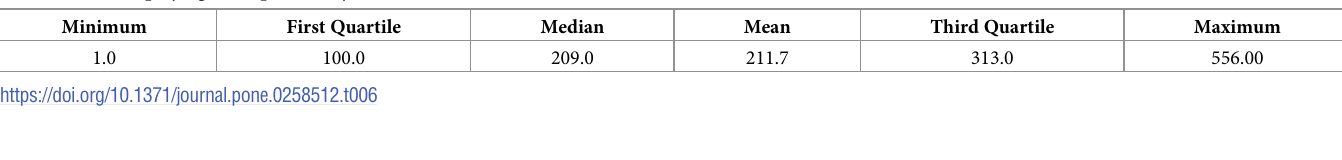
Table 4 shows the summary statistics for the real data. Fig 7 is the TTT plots of the dataset which shows a non decreasing curve. Fig 8 shows the fitted plot of the data using the MBTED and the competitive distributions. This indicated that the model fits the data. Table 5 reveals that the modified beta transmuted exponential distribution gives the best fit when compared to its submodels, due to lowest values of AIC, BIC, CAIC and HQIC therefore making it the preferred model to consider for this data.